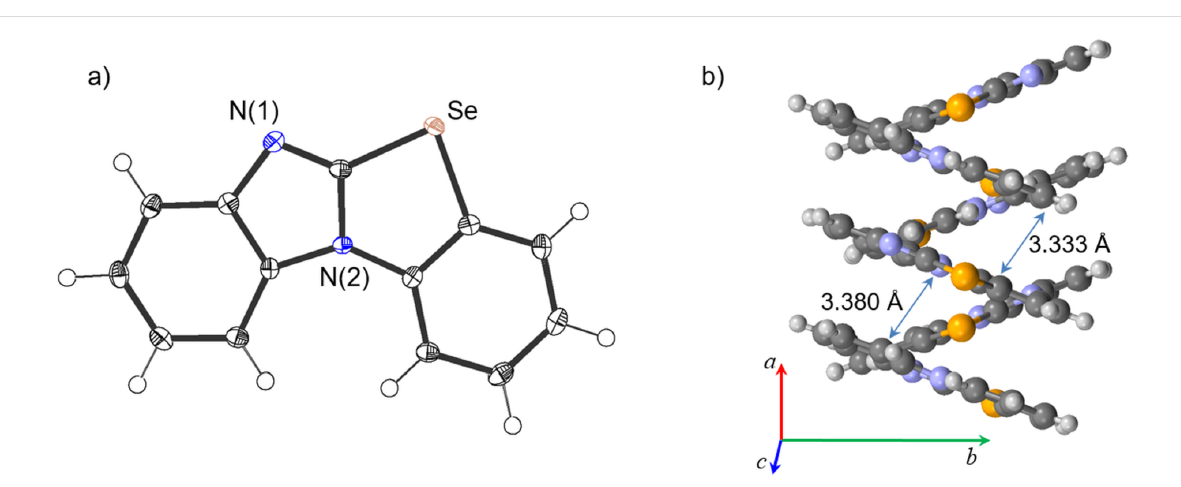
Figure 1: (a) Ortep drawing of 2a (50% probability, only one of two independent molecules is shown) and (b) packing structure. The component based solvent was omitted for clarity.